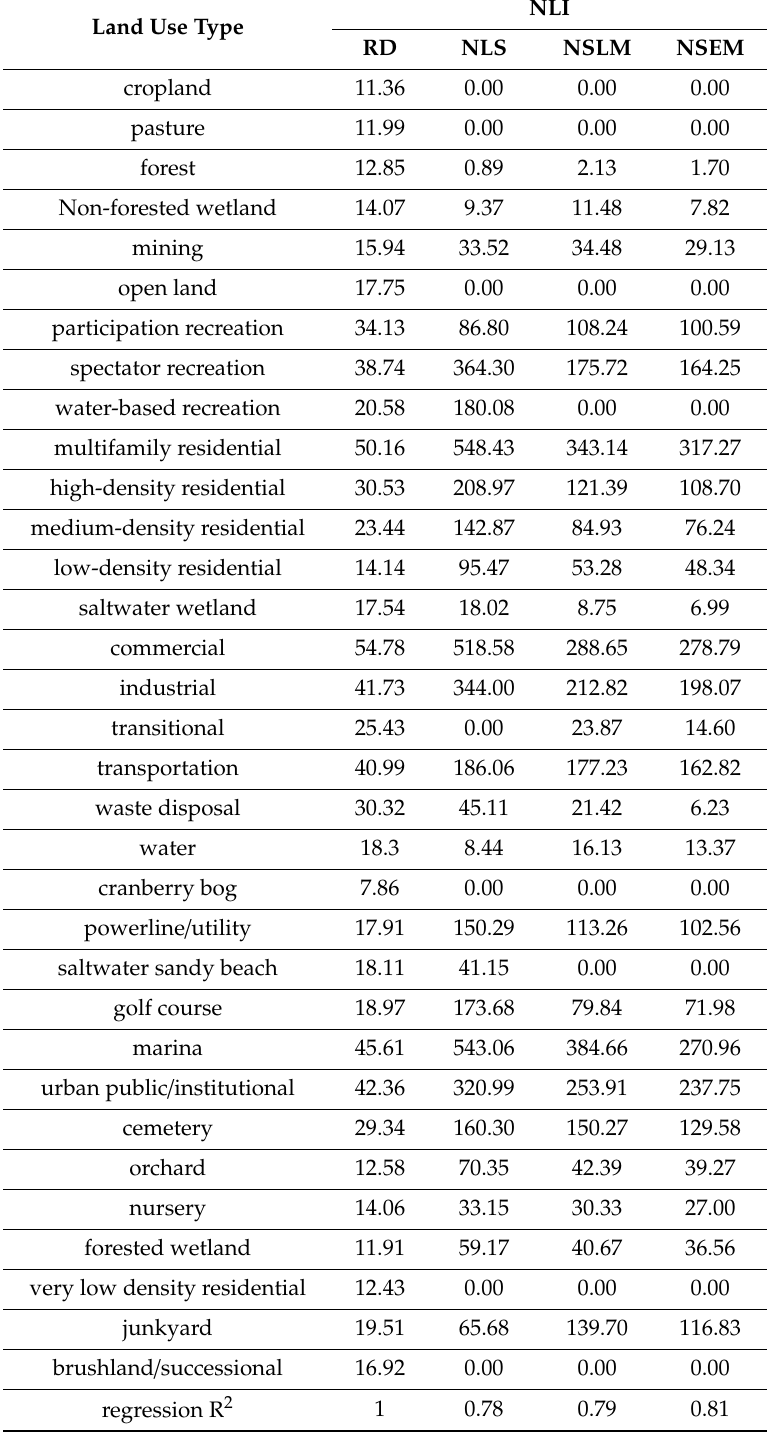
Table A2. NLIs of reference data (RD) and analysis data from di ff erent models in